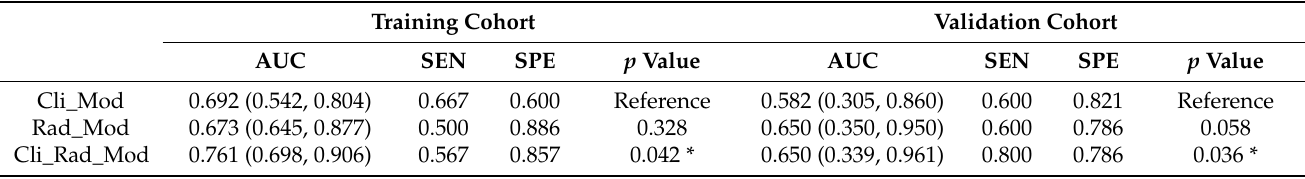
Table 6. Comparison of different models in training cohort and validation